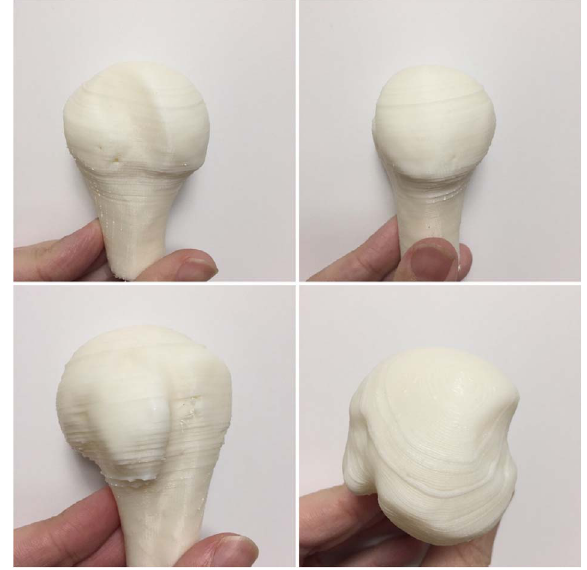
Figure 4. 3D Printed model of a humeral head defect. Figure 5. 3D Printed model of a glenoid with the location for screws and a 3D printed model of a patient-speci fi c guide to position the